Question: Briefly state, in one sentence, what is plotted here.
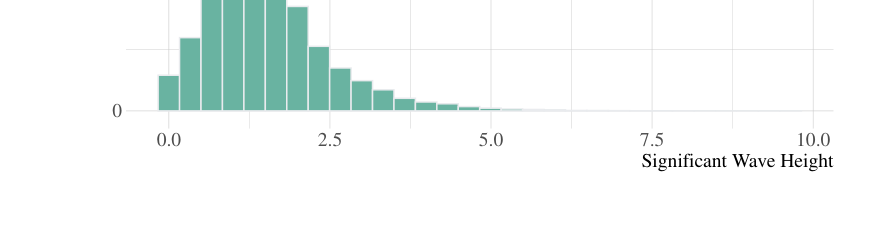
Answer: Histogram of the SWH time series distribution, which shows a positive skewness